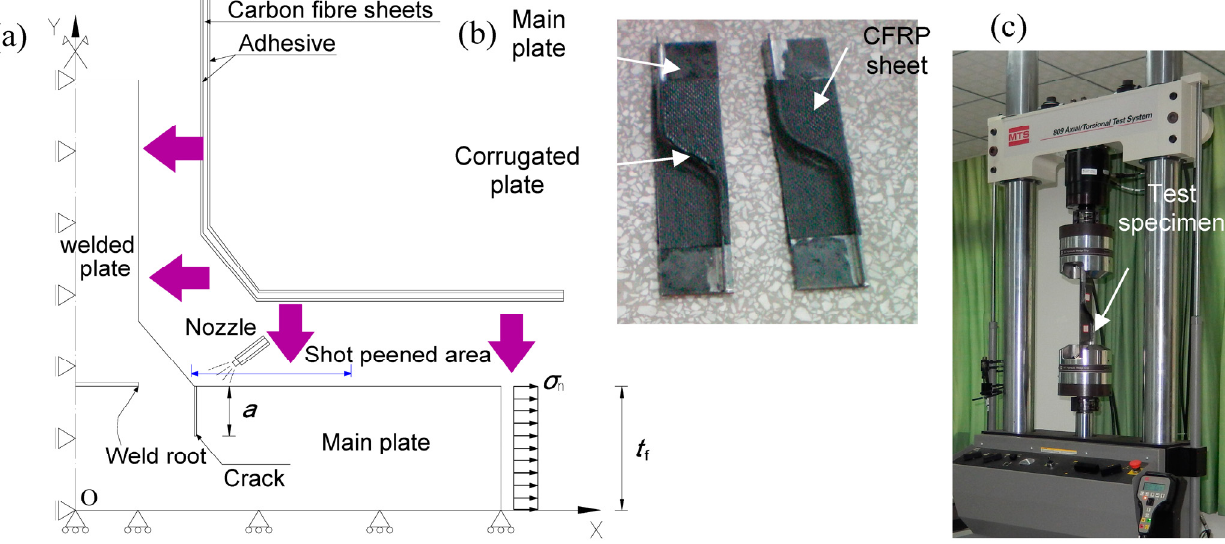
Figure 2. Test specimen with carbon fiber-reinforced polymer (CFRP) + shot peened area. ( a ) Conceptual model for analysis; ( b ) Test specimen; ( c ) Test set-up.